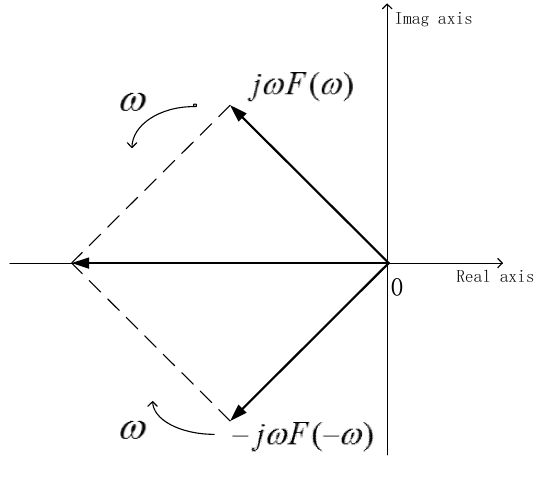
Figure 2. Two rotating phasors with the same frequency and opposite